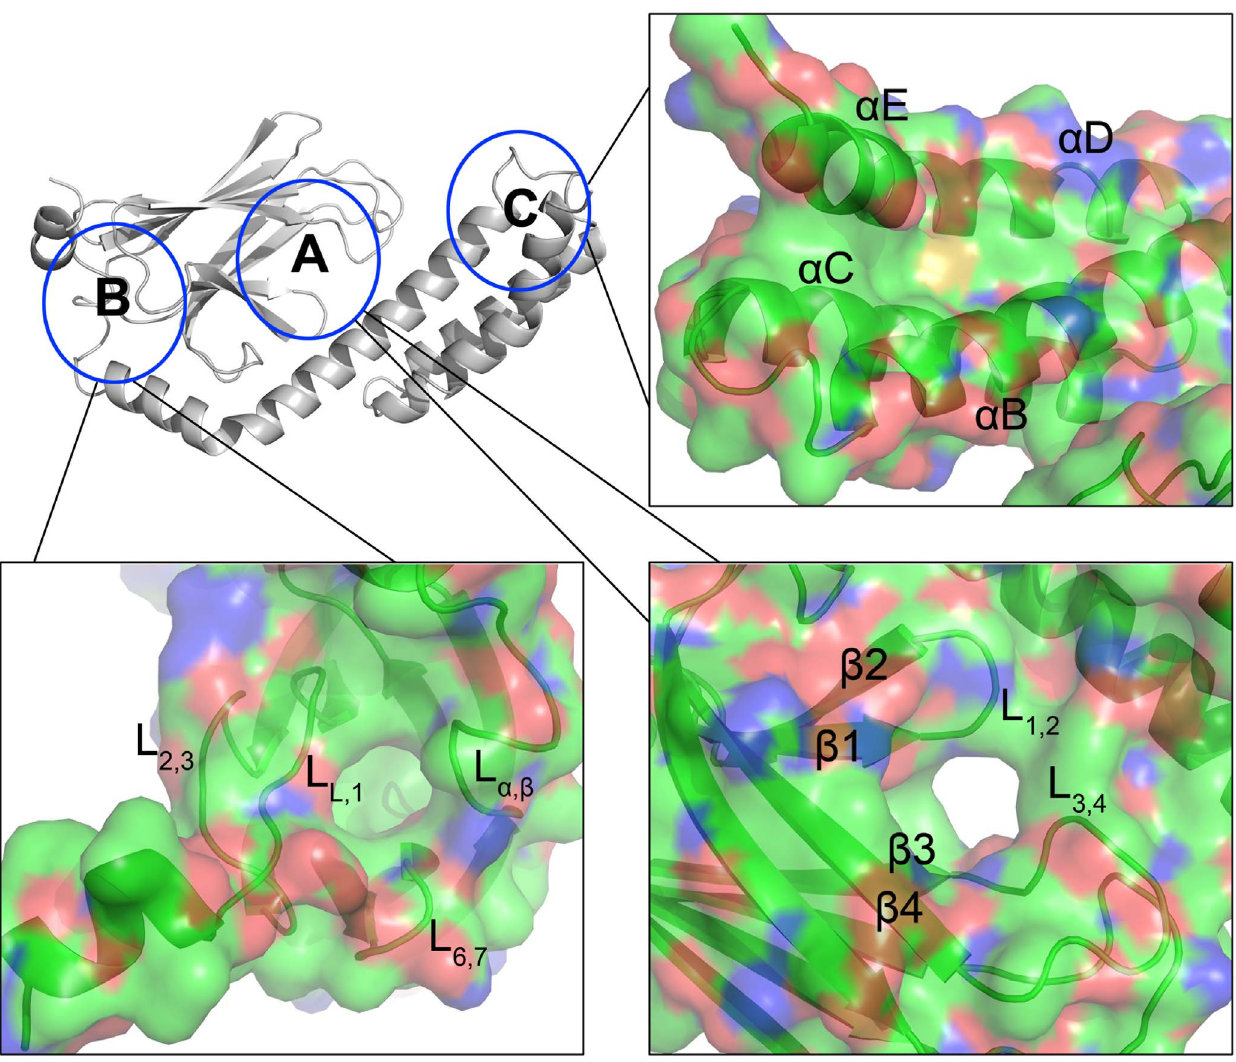
Figure 5. Putative druggable sites in the HSP70 SBD domain. An overview of three hydrophobic pockets within the SBD domain have been circled and marked as A, B and C. Close-up of the surface area of these three sites are illustrated in CPK coloring mode, with carbon in green, oxygen in red and nitrogen in blue. Secondary structural elements within the area are labeled. The NRLLLTG substrate is removed from this figure (pocket A) to better illustrate the pocket A for comparison with the other pockets (B and C).